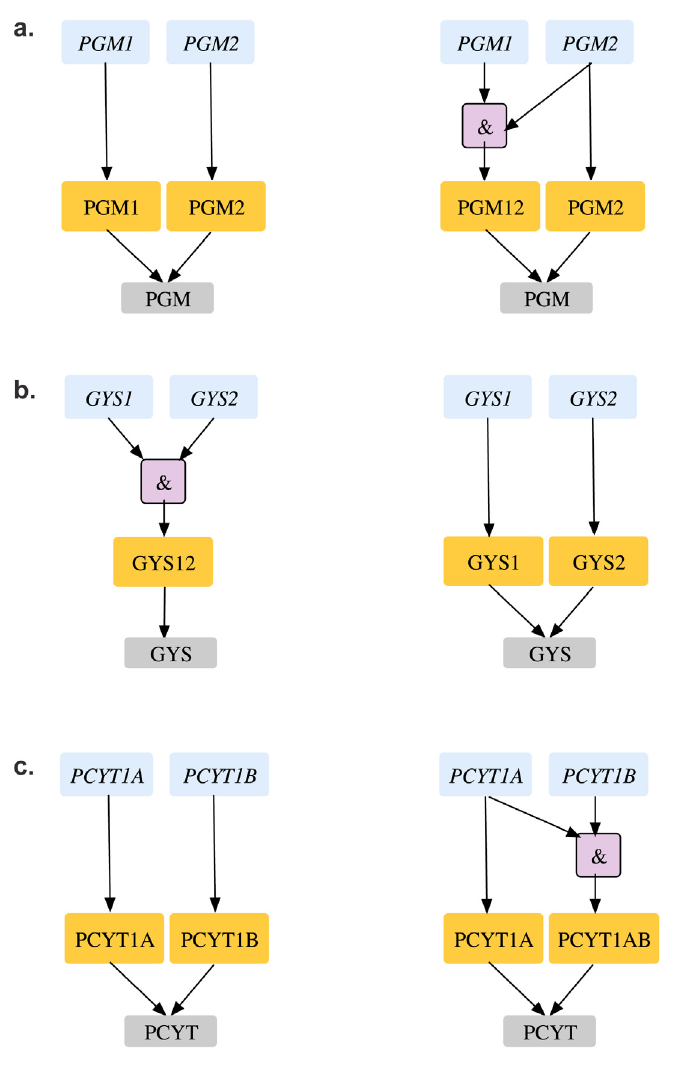
Figure 11. GPR modifications in CHO 1.2 model. ( a ). Reconciling gys1 and gys2 from essential genes to an SL2 ( b ). Shows how pgm2 can be identified as an essential gene ( c ). Shows how pcyT1a can be identified as an essential gene. Old GPR is shown on the left and new GPR on the